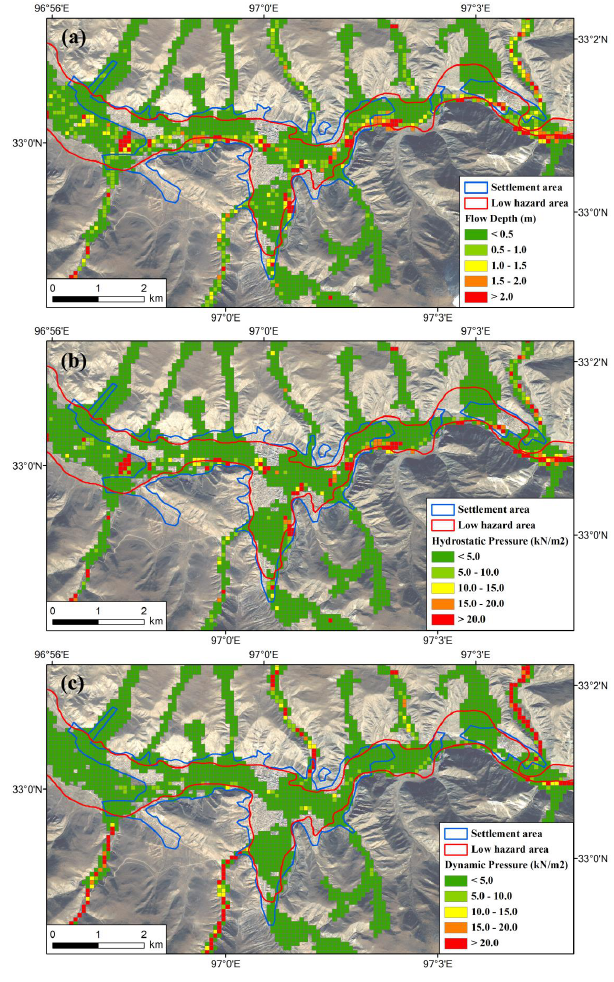
Fig. 5. The simulated debris flow event with a returning period of 100yr: (a) flow depth; (b) hydrostatic pressure; (c) dynamic pres-